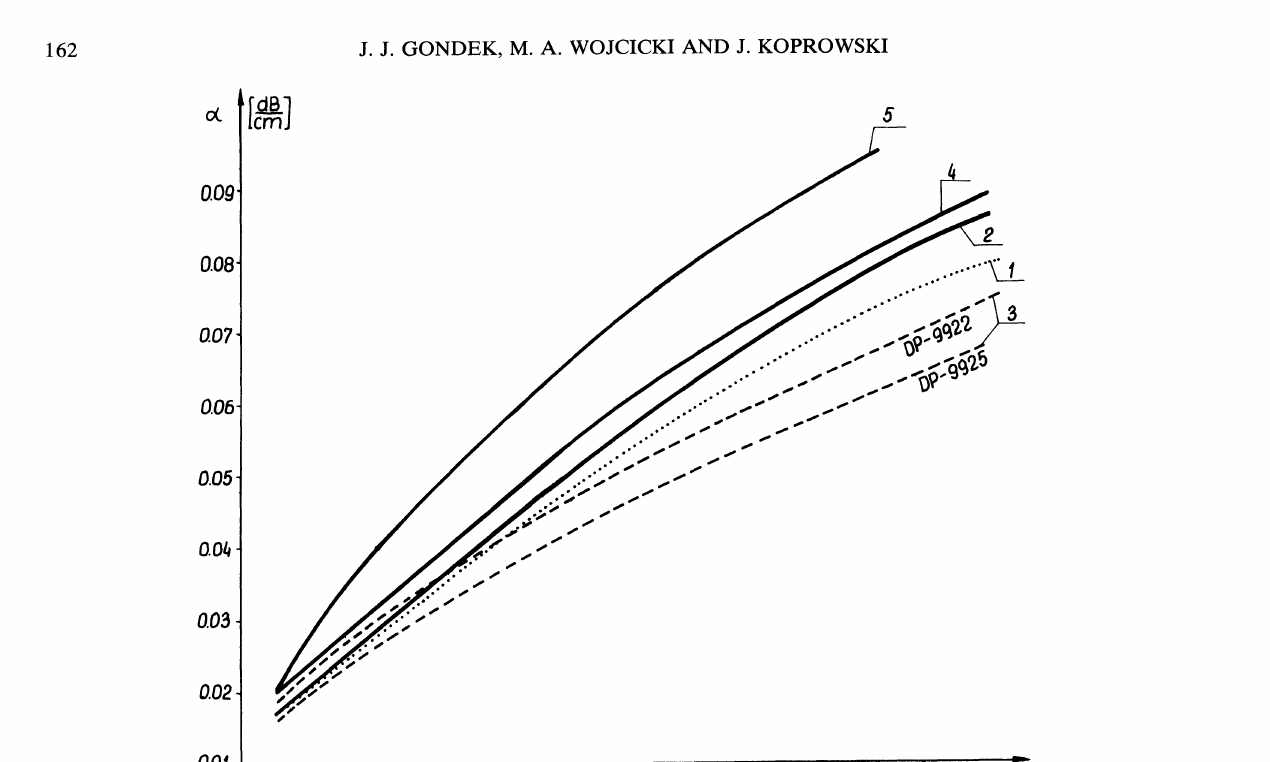
FIGURE 10 Frequency characteristics for attenuation in ASL obtained for copper pastes compared with other materials and technologies of ASL manufacturing, where: 1- Cr-Au thin-film on alumina substrate (6) 2- Copper thick film on alumina substrate, according to the authors of (6) 3- Copper thick-film from Du Pont paste on alumina substrate--obtained by the authors of this paper. 4- Copper thick-film on alumina substrate according to (6) 5- 10Z--Copper on Epsilam 10 or 6010 according to